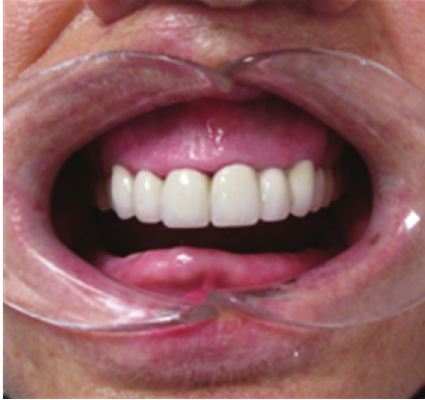
Figure 1: Intraoral view of the patient.